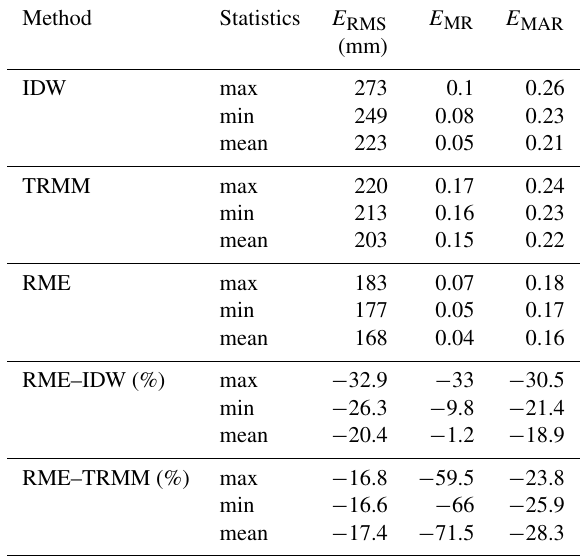
Table 3. Performance comparison between IDW, RME, and